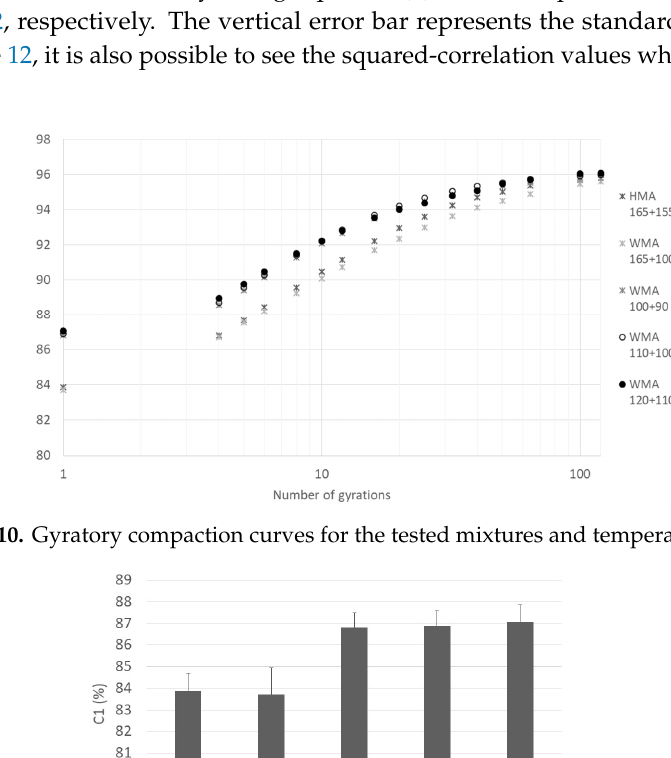
Figure 12. Variation of K parameter with mixture and temperature and corresponding squared- correlation values. From the figures, it is possible to separate the mixtures into two sets, the ones produced at a higher temperature (mixing at 165 °C) and the others produced at lower temperatures. The first set includes the HMA and the WMA produced at 165 °C and transported for a long distance (higher haulage distance). The mixtures on the second set (WMA produced at lower temperatures) presents better compaction than the mixtures on the first set (HMA and WMA for higher haulage distances). Concerning the WMA mixtures produced at lower temperatures, the variation of the degree of